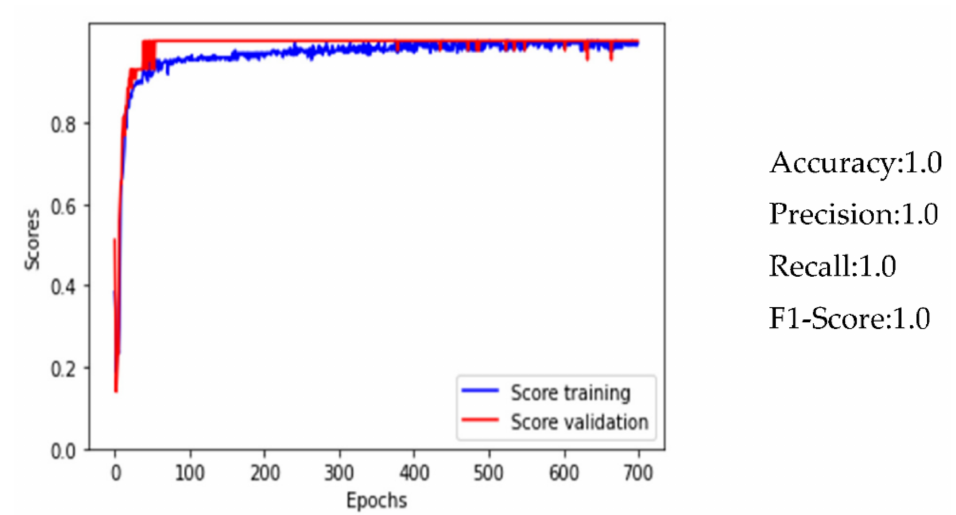
Figure 14. Application of the ANN method with pressure data.